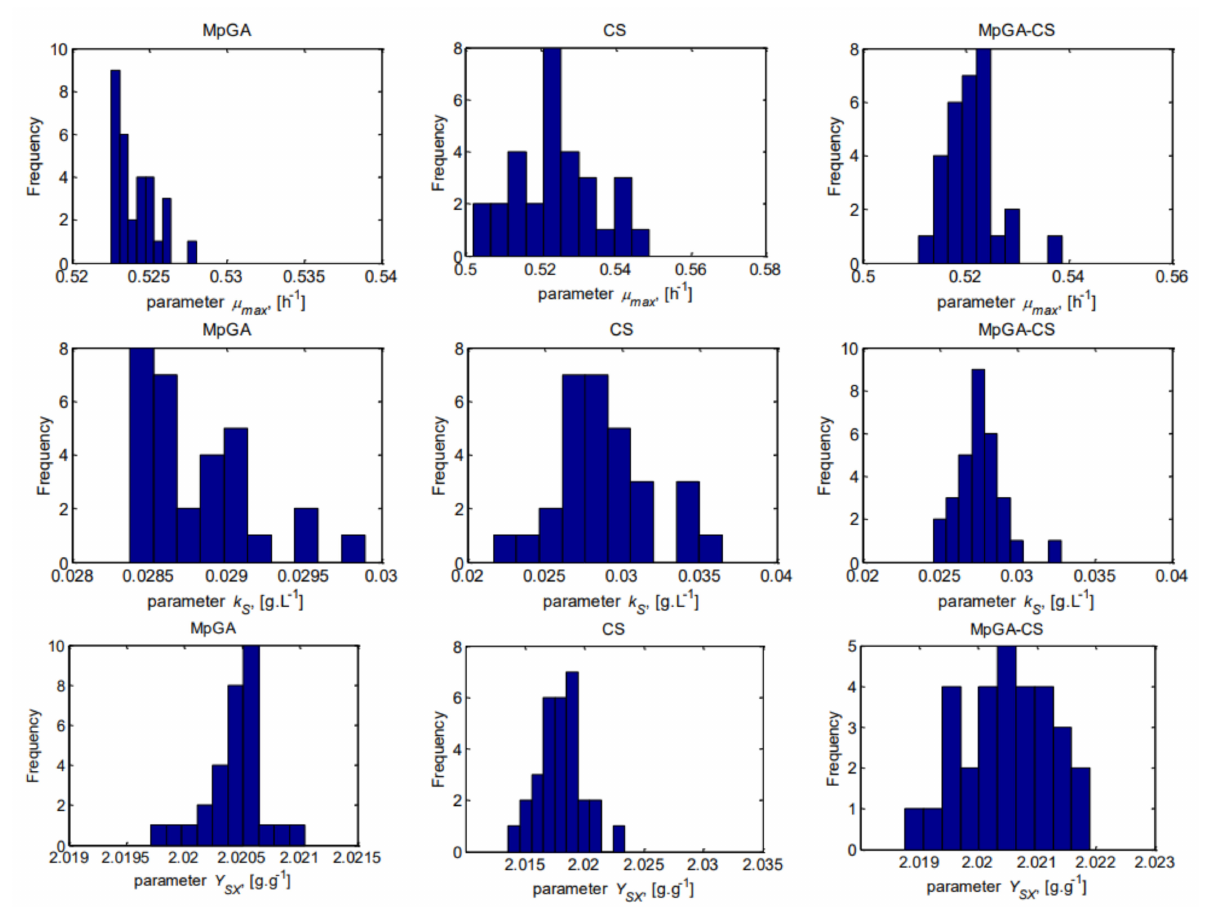
Figure 6. Histograms of the results for model parameter estimates from parameter identification of E. coli FP model (30 runs).